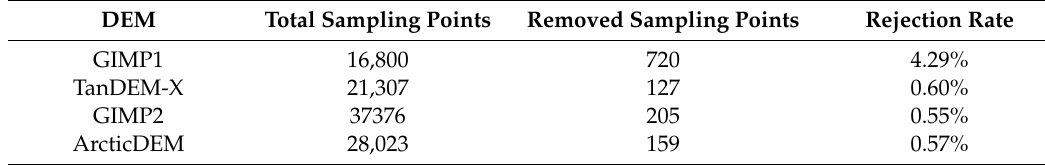
Table 5. Outlier removal from the sampling